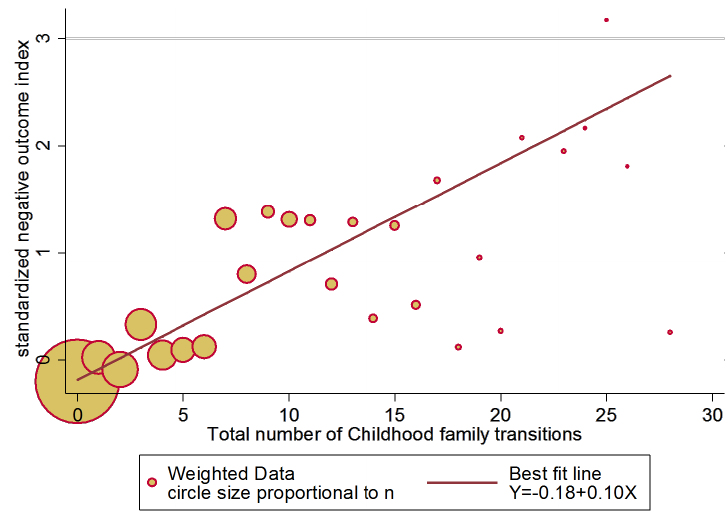
Figure 1: Negative Outcome Index as a Function of Childhood Family Transitions Source: NFSS data, weighted by “weight4.” N = 2,466 Source: NFSS data, weighted by “weight4.” N =